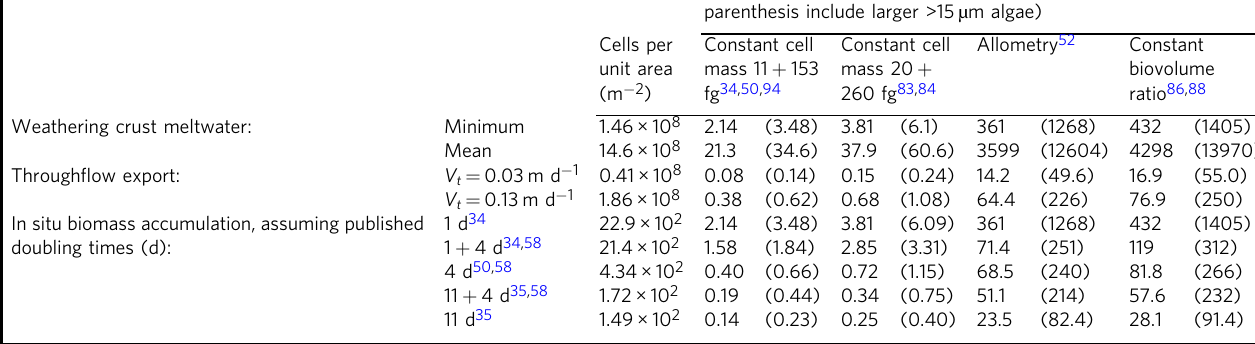
Table 1 Catchment-wide microbial abundance and carbon biomass estimated using bacterial and algal cell constants, allometric and constant ratios, and using published supraglacial community doubling times over a single day residence